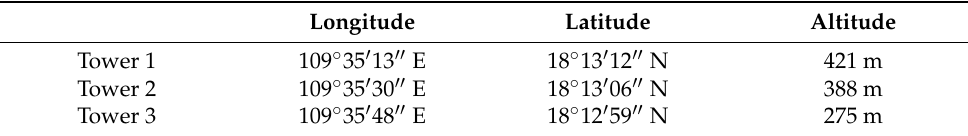
Table 1. The longitudes, latitudes, and altitudes of the three towers. Longitude Latitude Altitude Tower 1 109 ◦ 35 (cid:48) 13 (cid:48)(cid:48) E 18 ◦ 13 (cid:48) 12 (cid:48)(cid:48) N 421 m Tower 2 Tower 3 275